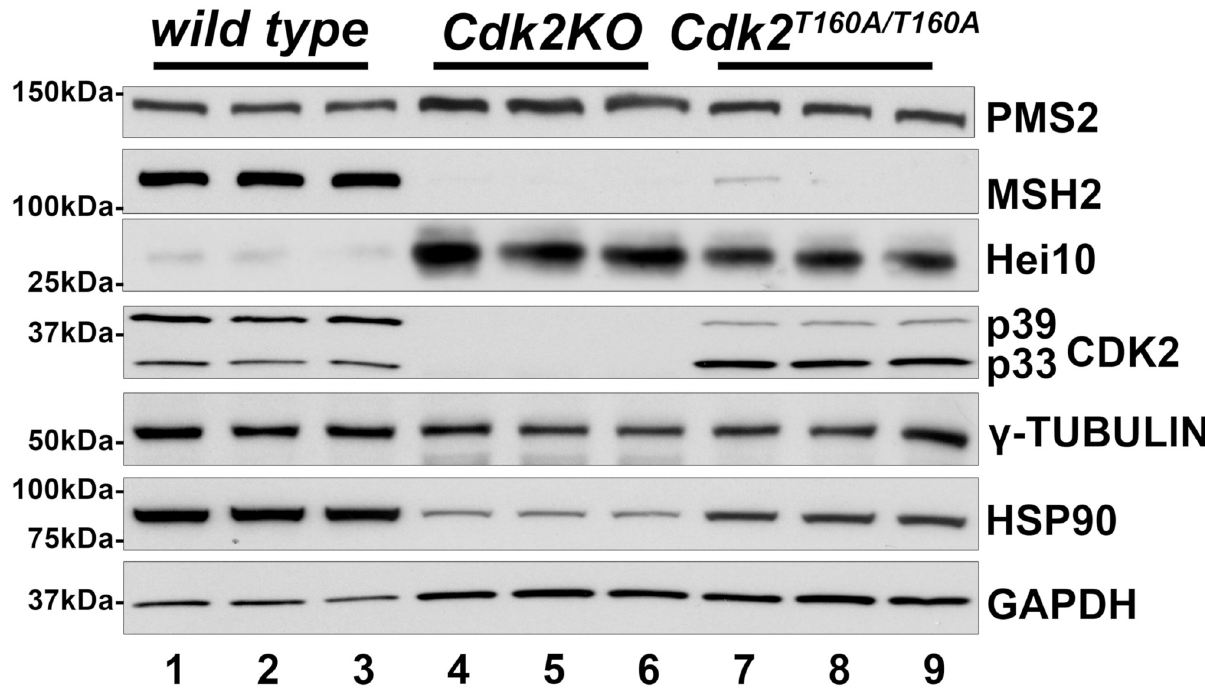
Fig 3. Protein analysis in WT, Cdk2KO , and Cdk2 T160A testis. Western blot analysis of testis lysates extracted from p56 wild type (lanes 1–3), Cdk2KO (lanes 4–6) or Cdk2 T160A (lanes 7–9) mice. Different biological replicates are used for each lane shown. gamma-TUBULIN, GAPDH, and HSP90 are shown to indicate equal loading of each lane. Molecular weight markers in kDa are shown on the